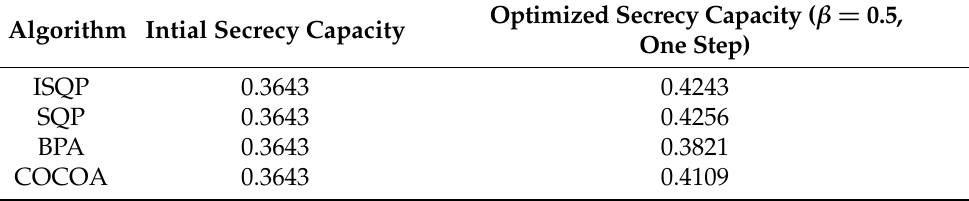
Table 7. Secrecy Capacity Comparison for SISO under Perfect Channel Estimation.